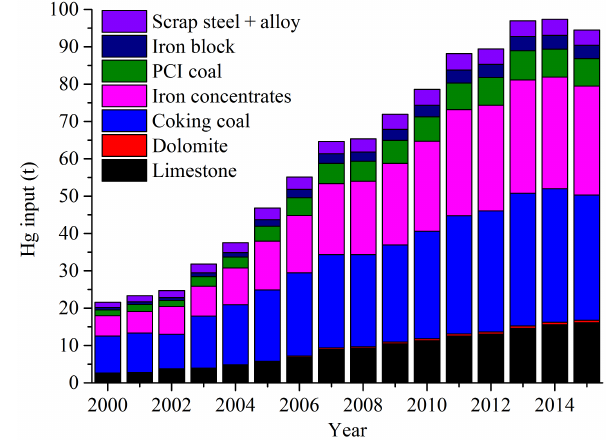
Figure 3. Hg emission trends by process and Hg removal